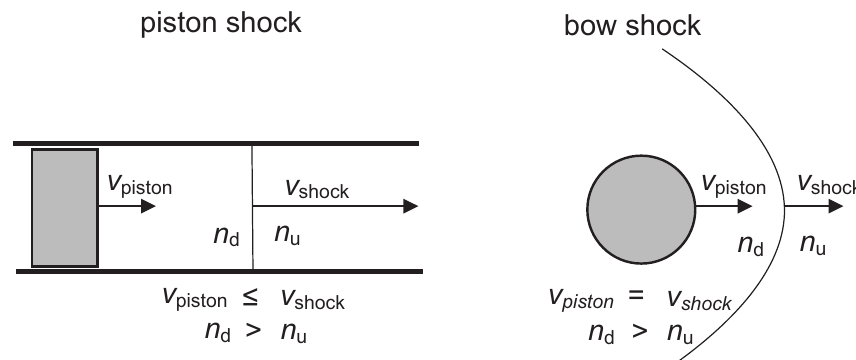
Figure 2: Schematics of the two types of driven shocks: piston-driven shock ( left ) and bow shock ( right ). In a piston-driven shock, the driver can be slower then the shock ( 𝑣 piston ≤ 𝑣 shock ), while a bow shock always has the same speed as the driver ( 𝑣 piston = 𝑣 shock ). Adapted from Warmuth